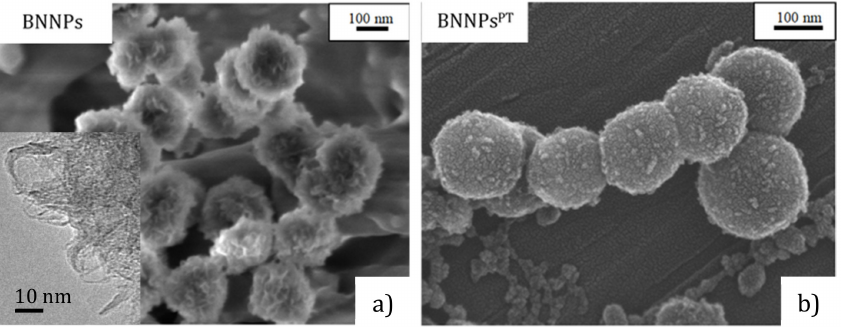
Figure 1. SEM ( a , b ) and TEM (inset in ( a )) images of BN nanoparticles (BNNPs) and their conjugates.